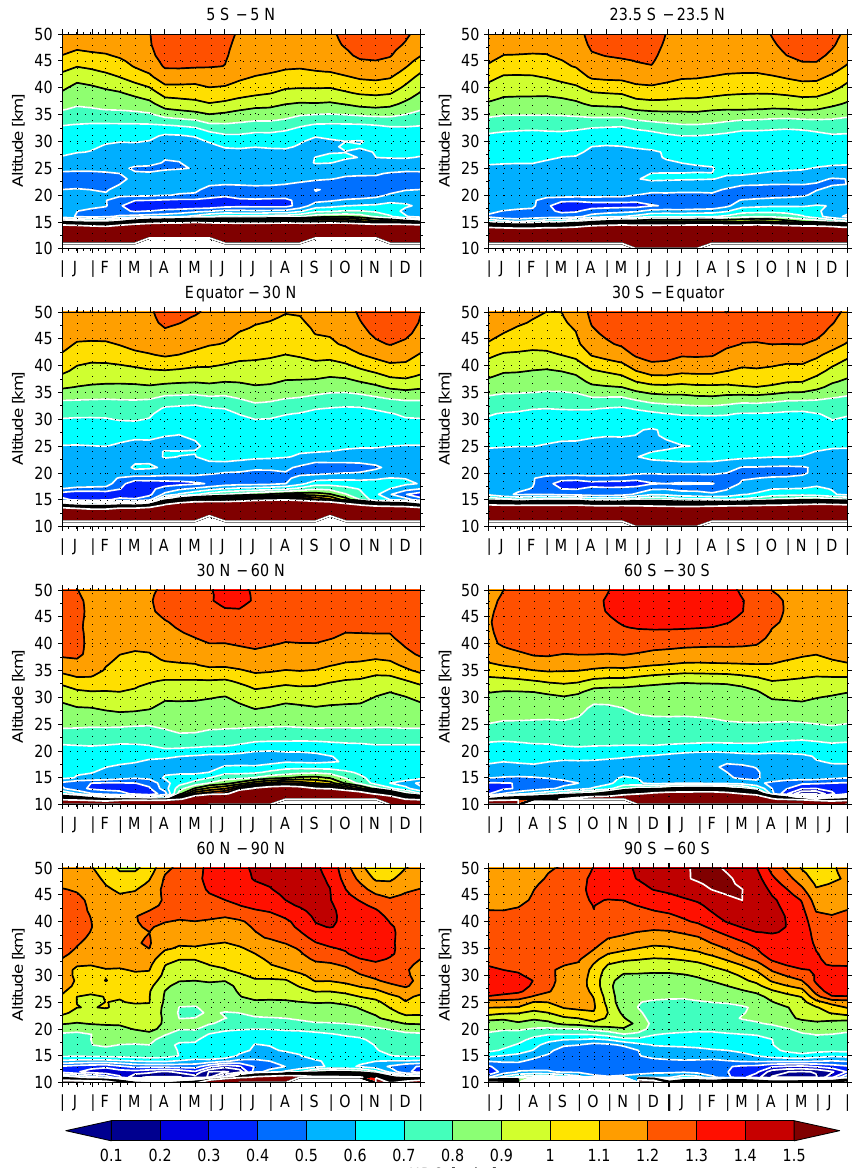
Fig. 1. Mean annual cycle of HDO for different latitude bands derived from the Envisat/MIPAS observations between June 2002 and March 2004. Please observe that the time axis of the panels that show the annual cycle in the mid-latitudes and polar regions (last two rows) has been adjusted so that the summer season always occurs in the middle of those